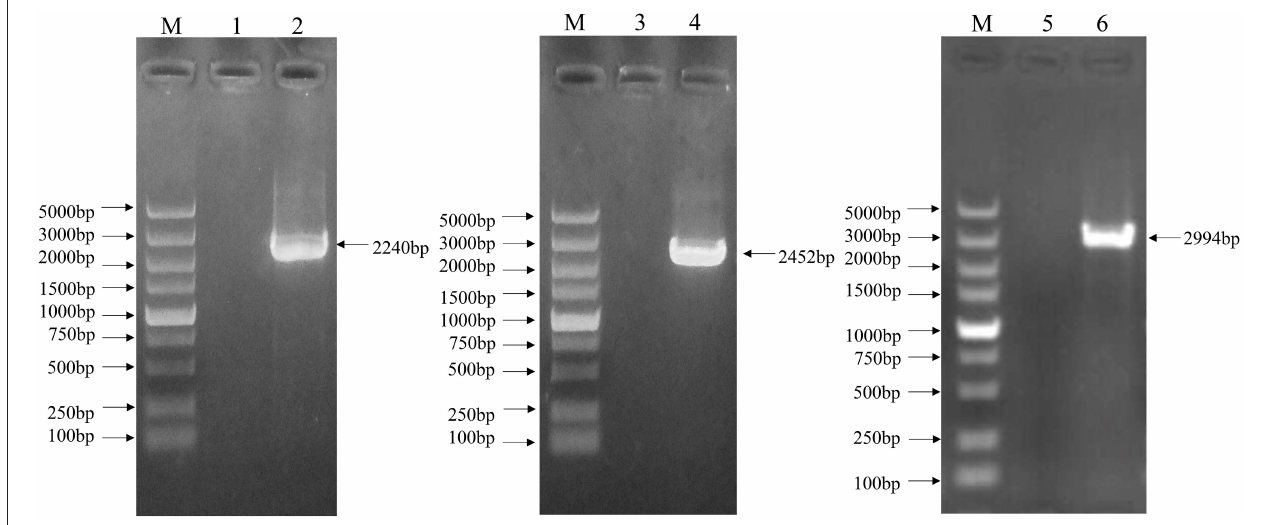
FIGURE 4 | The complete genome identification of the EV-G CH/17GXQZ/2017 strain by RT-PCR. Amplification of the complete genome of the EV-G CH/17GXQZ/2017 strain. Lane M, DNA marker DL5000; Lanes 1, 3, and 5, negative controls; Lanes 2, 4, and 6, three overlapping PCR products of viral genome from the EV-G CH/17GXQZ/2017